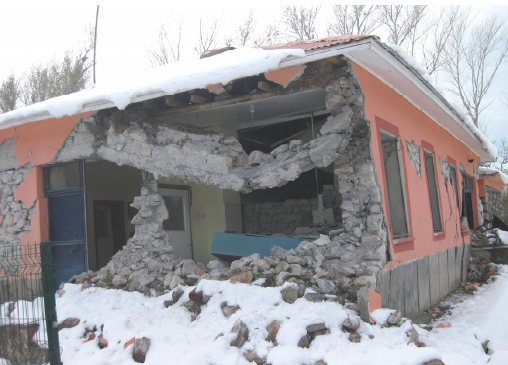
Fig. 12. Out of plane failure.